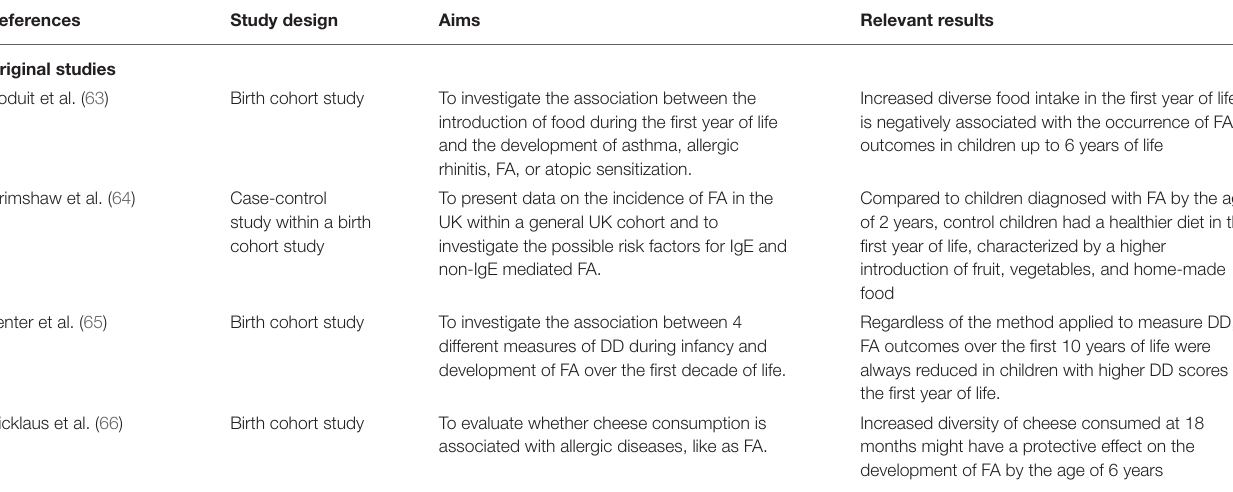
TABLE 1 | Overview of the original studies exploring the effects of diet diversity for the prevention of food